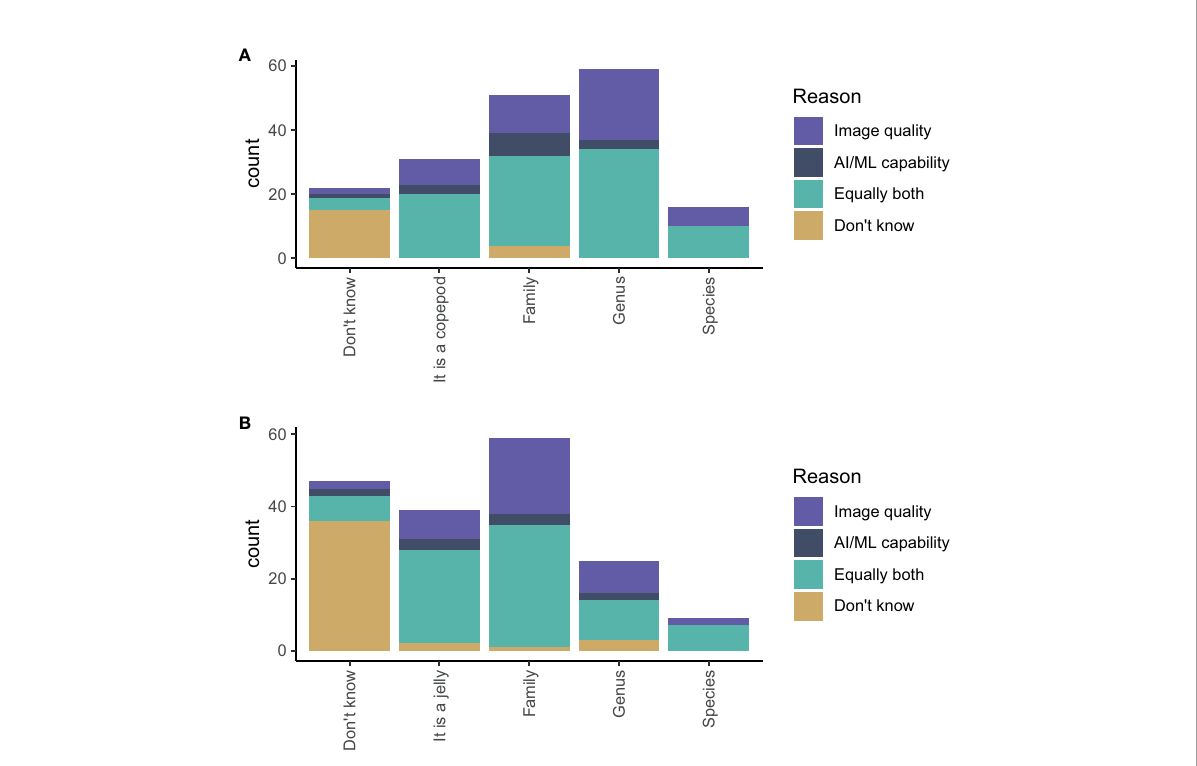
FIGURE 8 Estimates of the highest taxonomic level an AI/ML algorithm can positively identify (A) a copepod and (B) a gelatinous zooplankton using images generated from an appropriate imaging system. The colours show whether a participant ’ s answer was most in fl uenced by their understanding of image quality (purple), the capability of AI/ML (dark blue), equally both (turquoise), or unknown (yellow).